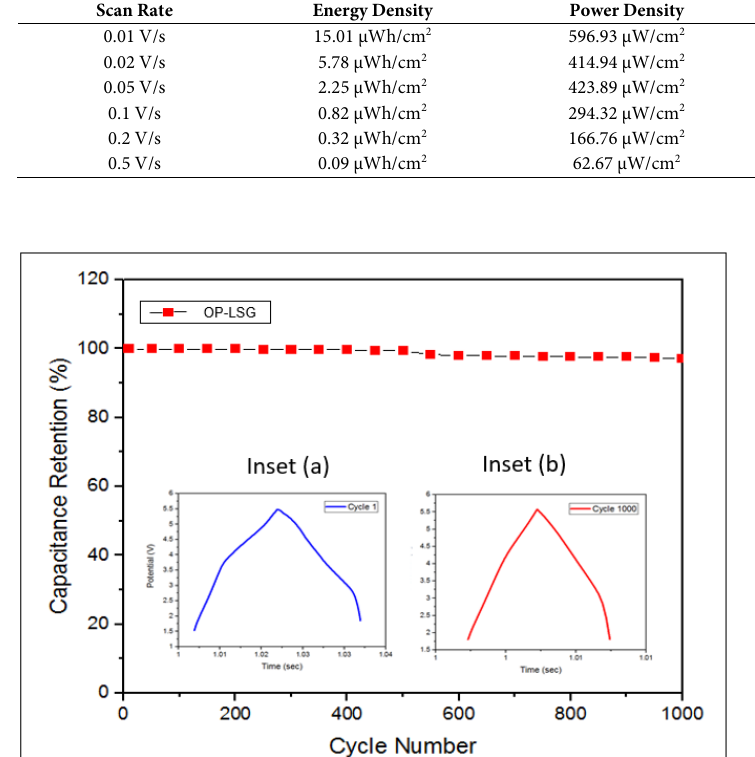
Fig. 8. Capacitance retention of OP-LSG for 1000 charge-discharge cycles. Inset (a), GCD Curve at 1 st cycle. Inset (b), GCD curve at 1000 th